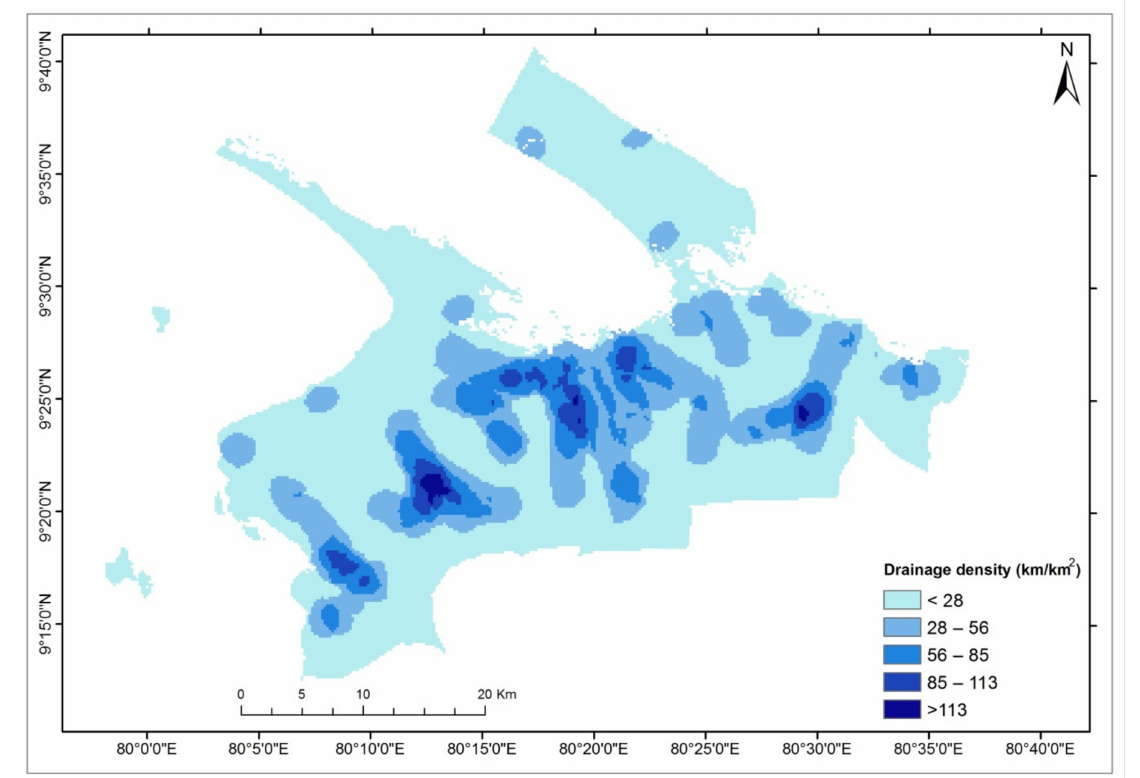
Figure 8. Drainage density map of Kilinochchi